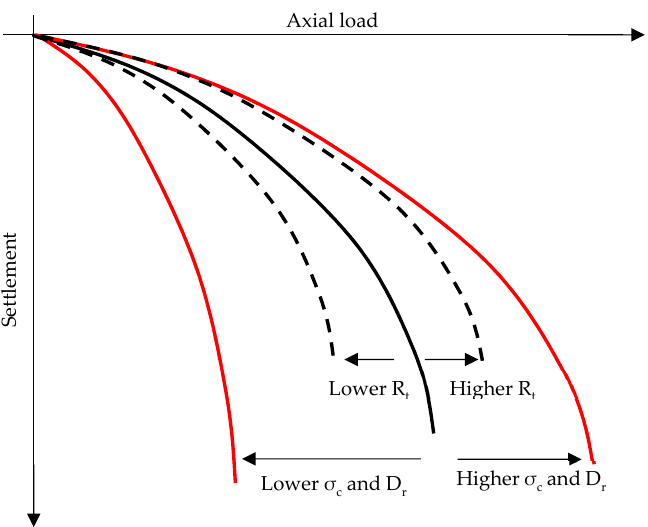
Figure 13. Surface roughness (R t ), confined pressure ( σ c ), and relative density (D r ) affecting the behaviour of FRP piles under an axial load.